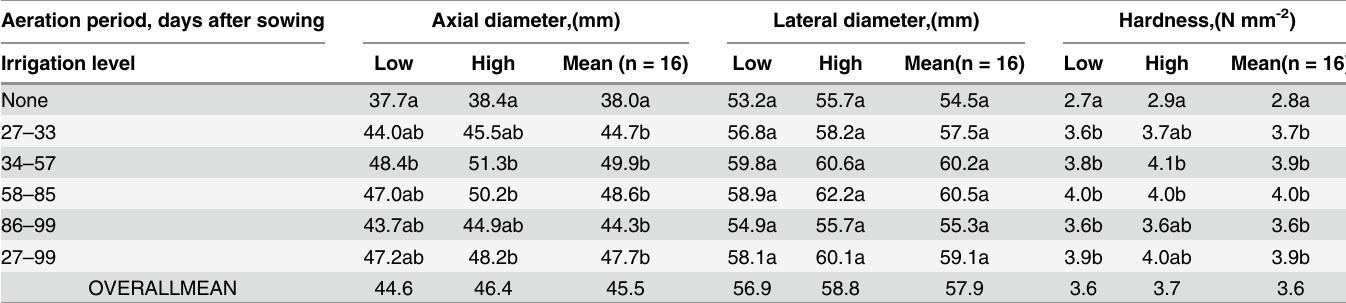
Table 5. Axial and lateral diameter, and hardness measured on the first 8 ripe fruits harvested from the first trusses of 3 potted single tomato plants for 6 post-infiltration aeration treatments (i.e. none or 2.5 liter aeration applied during 5 different periods). Pots were subsurface drip-irrigated at 2-day intervals to maintain the soil at 60 to 70% or 70 to 80% of volumetric field capacity (denoted as low and high irrigation level). Aeration period, days after